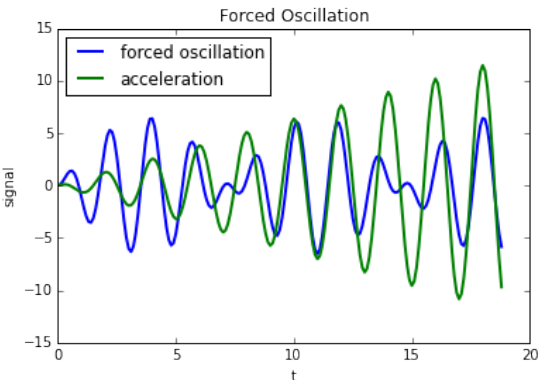
Figure 3. Two different regimes of a forced oscillation. Blue: scale interaction without amplification; green: amplification of